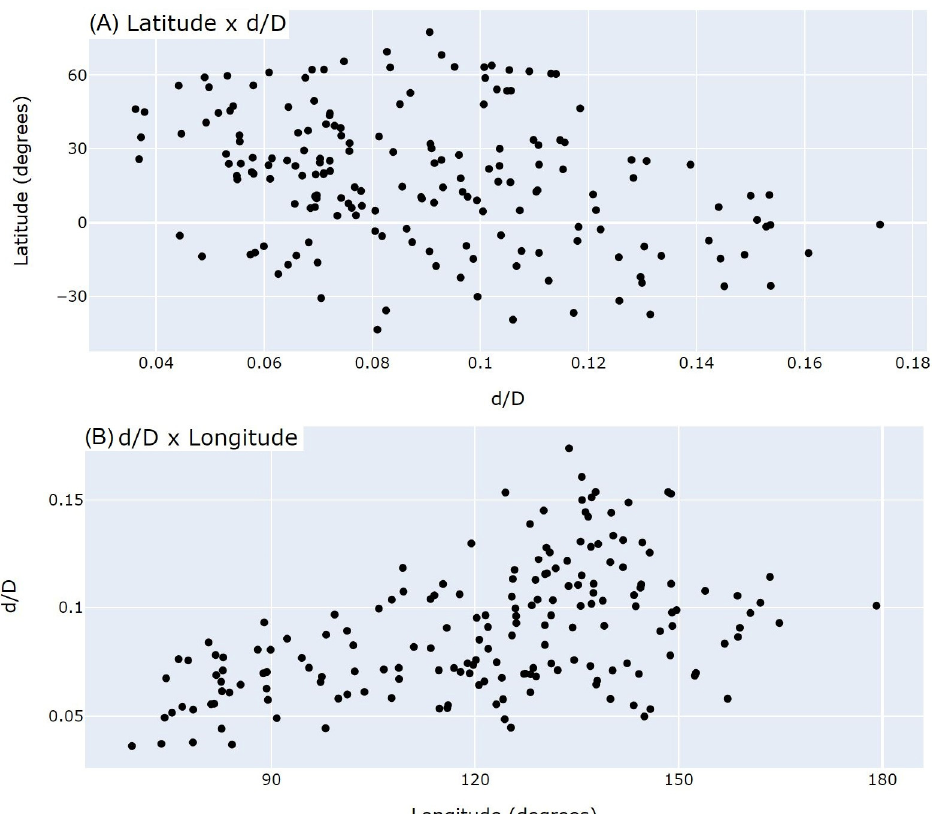
Figure 5. d/D ratios related only to freshest craters plotted according to: ( A ) latitude; ( B ) longitude. In order to better understand the variability of morphometry across Pluto’s surface, areas of common d/D patterns were grouped together, using Figures 5 and 6, in five dif- ferent regions (Figure 6B).